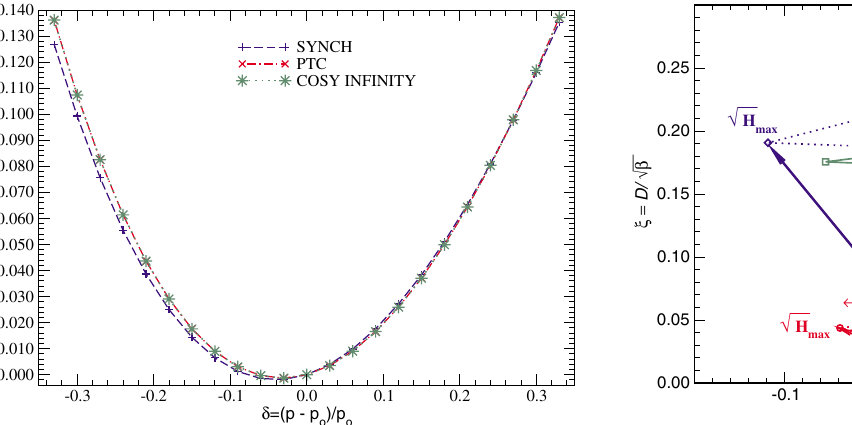
FIG. 6. (Color) Normalized dispersion function in the basic cell for three designs: FODO cells, doublets, and our triplets using the same magnets.